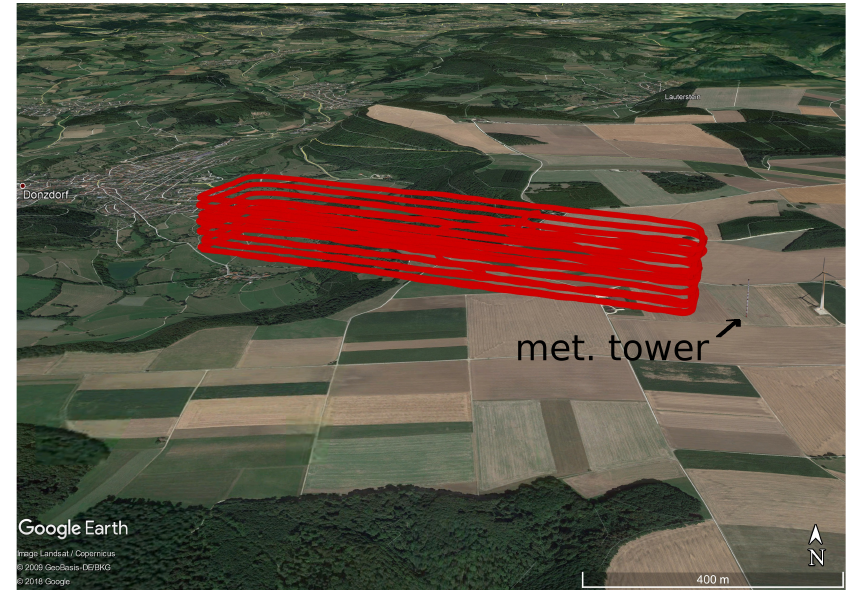
Figure 7. Flight path (so-called racetracks) in red in Schnittlingen (SNT) on 7 May 2015, with the meteorological tower east of the flight path. During the measurement, moderate westerly winds prevailed. The crest forms partial up-drafts and strongly sheared